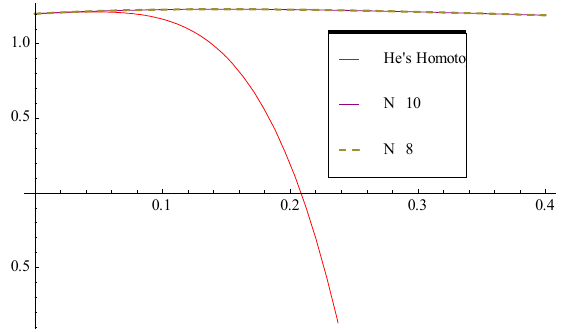
τ ) at di ff erent N with He’s Homotopy solution.    v at different N with He’s Homotopy solution. Figure 7. Approximate solution v N ( N    v at different N with He’s Homotopy solution. N